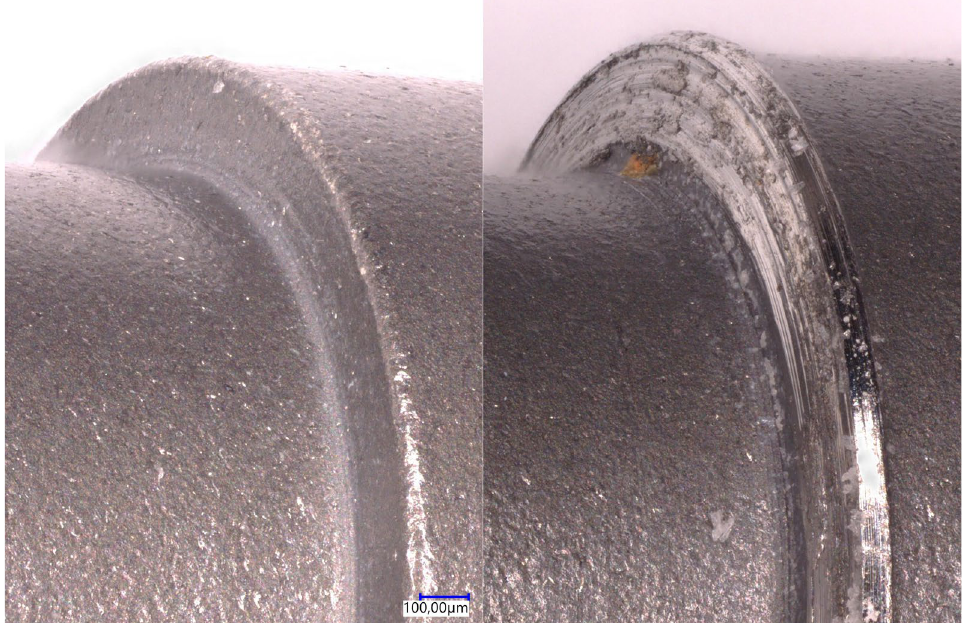
Fig. 8 SEM photomicrograph (50x) of the bearing surface of the screw head before (left picture) and after (right picture) ten tightening